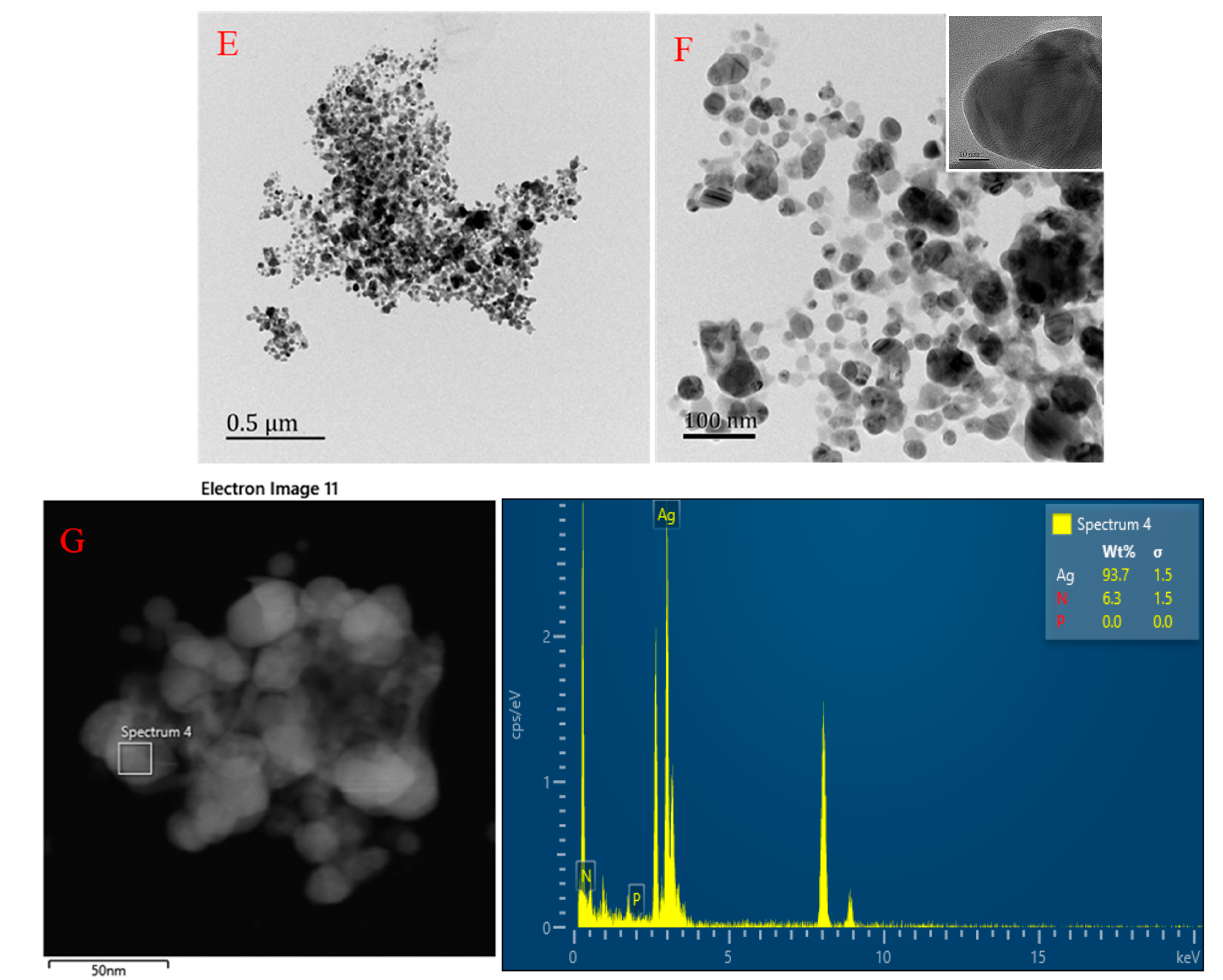
Figure 5. TEM and EDS. ( A , B ) TEM of AgCOF; ( C , D ) mapping EDS of AgCOF; ( E , F ) TEM of AgNP; ( G ) EDS of AgNP.